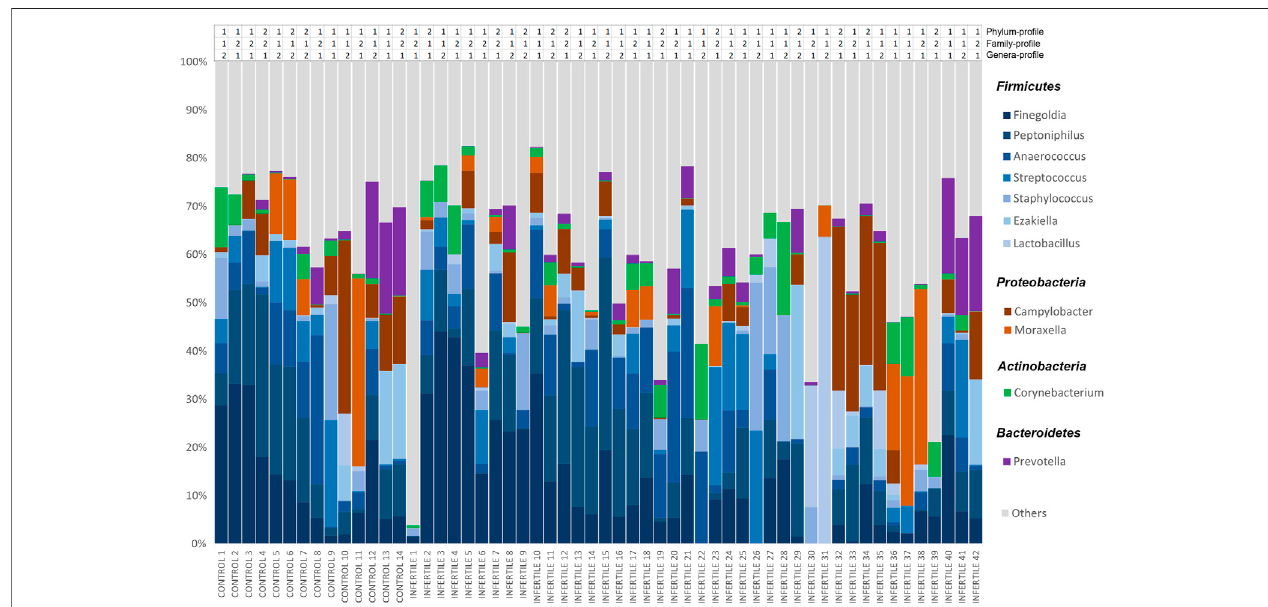
FIGURE 1 | Relative abundances of bacteria included in seminal microbiome from control donors and idiopathic infertile patients at genus level. The X -axis shows each individual of our cohort, and the Y -axis corresponds to the relative abundance of each taxon in percentage. Clustering-based bacterial pro fi les to which each individual belongs is shown above the bar-graph at phylum, family and genera